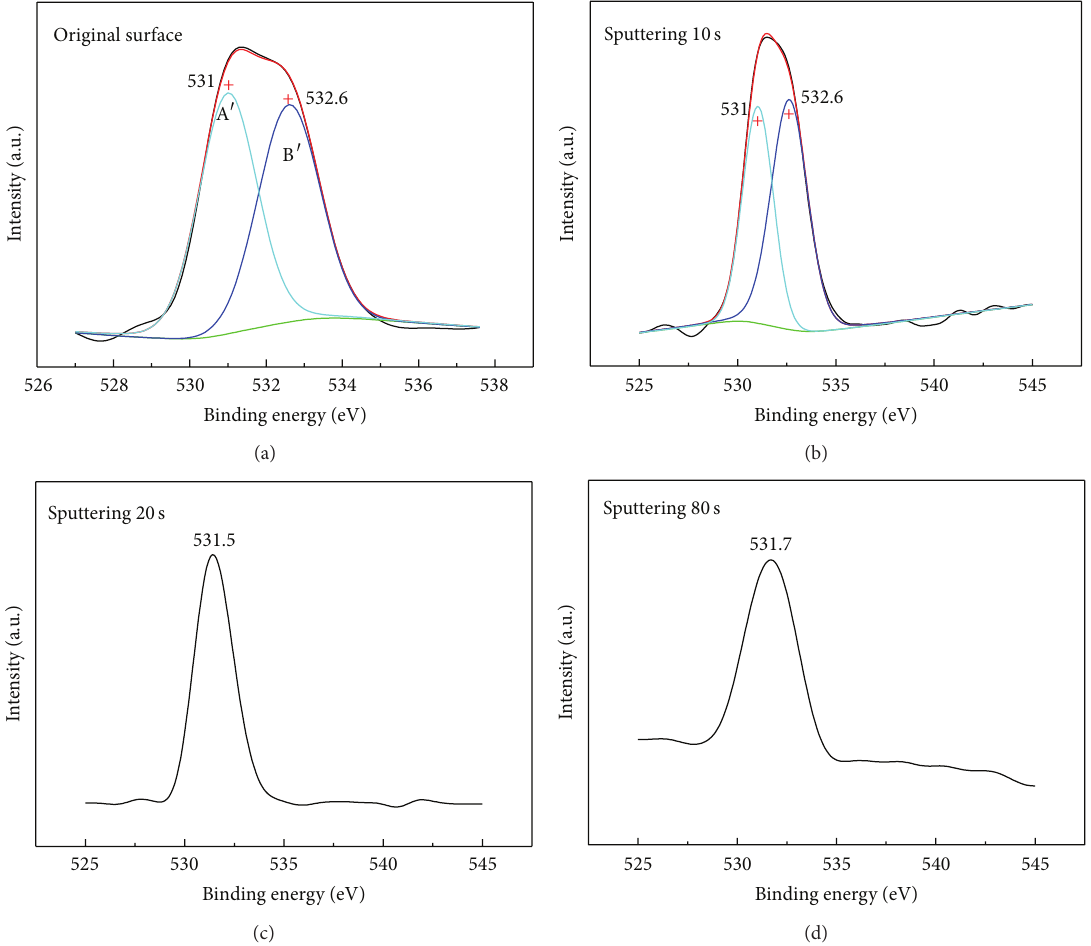
Figure 6: O 1s spectra of SBZA sample exposure at 170 ∘ C for 7 min after etching for (a) 0 s (initial surface), (b) 10 s, (c) 20s, and (d) 80